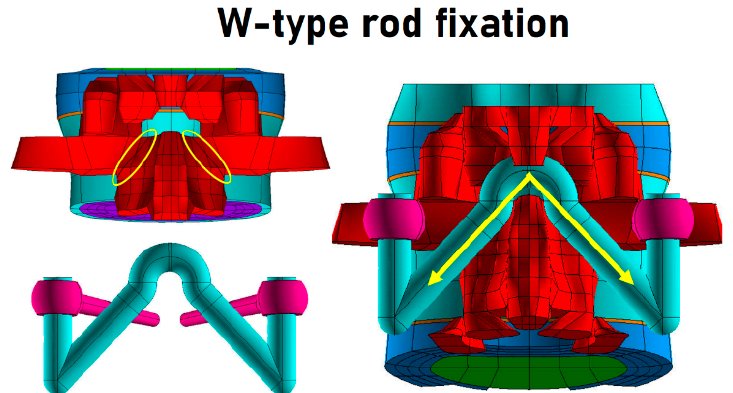
Figure 4. Construct of the W-type fixation. The pars fracture (yellow ellipse) induces spinal insta- bility. The W-type rod (yellow arrow) creates a new loading pathway. The W-type rod (yellow arrow) creates a new loading